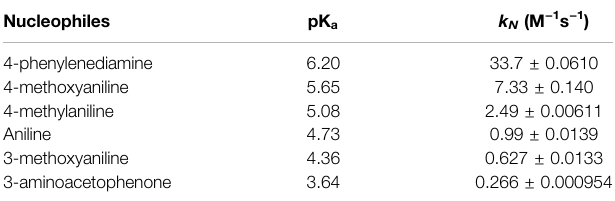
TABLE 2 | Aniline serie and their pK a values in water and k N values for the nucleophile series with 2-chloro-5-nitro pyrimidine.